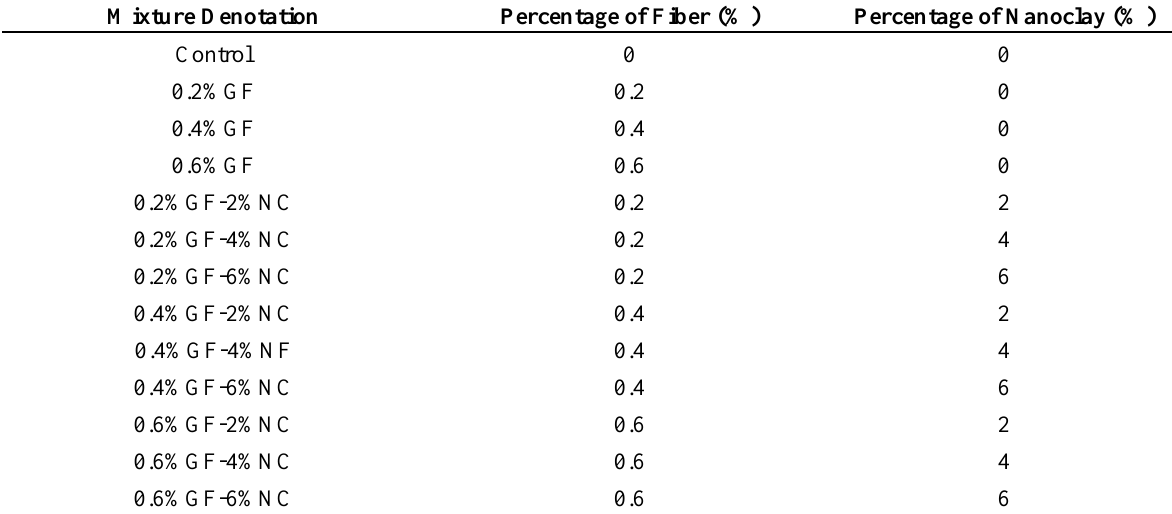
Table 6. Mixtures used in this research Mixture